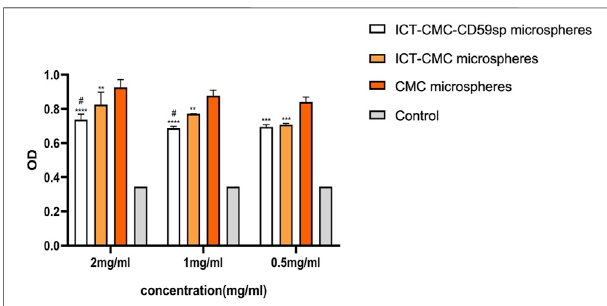
FIGURE 9 | Effect of ICT-CMC-CD59sp targeting of microspheres on tumor necrosis factor- α (different concentrations of each group compared with ICT-CMC-CD59sp microsphere group, ** p < 0.01, *** p < 0.001; CMC microsphere group compared with ICT-CMC microsphere group, # p <